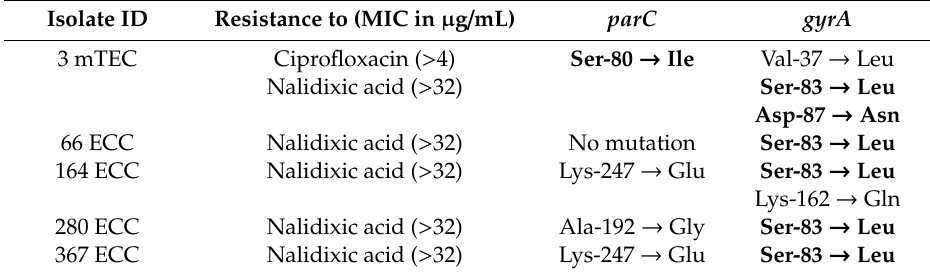
Table 3. Mutations in the parC and gyrA genes of the ciprofloxacin- and nalidixic-acid-resistant E. coli isolates from surface